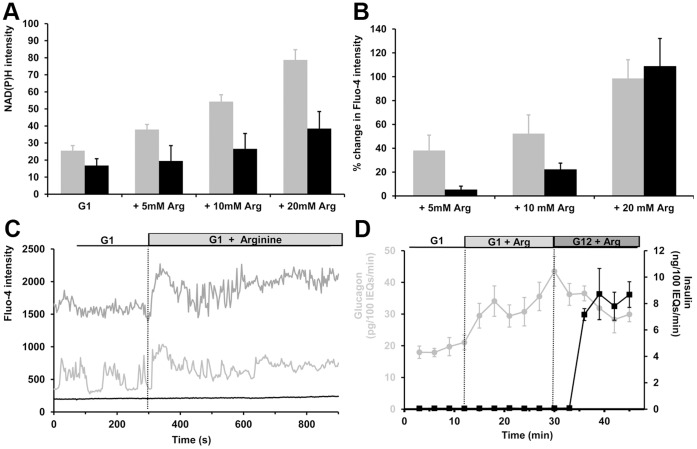
Effects of L-arginine on islet NAD(P)H, [Ca2+]i, and hormone secretion.Gray and black columns and traces represent α- and β-cells, respectively. A, arginine-dependent NAD(P)H responses from intact islets. Islets were perifused at 1 mM glucose (G1) and exposed to step-increases in arginine concentration. Data are normalized to minimal and maximal β-cell NAD(P)H obtained with FCCP and cyanide, respectively. The α-cell NAD(P)H changes to arginine (Arg) were statistically significant (p<0.01, 32 α-cells measured from 10 islets, 3 mice) and α-cell NAD(P)H intensity was different from β-cell intensity for each condition tested (p<0.01). Error bars indicate the standard error of the mean. B, averaged intracellular calcium responses to arginine. Data are expressed in percent change in Fluo-4 intensity compared to baseline at 1 mM glucose. α-cell responses to arginine were significant at all concentrations (p<0.01, n = 42) and β-cell responses were significant at 10 and 20 mM arginine (p<0.01, n = 11). C, intracellular calcium responses to 10 mM arginine from an islet perifused at 1 mM glucose (G1). 2 α-cells from the same islet are presented. Fluo-4 intensity is expressed in arbitrary units. The figure is representative of 11 α-cells from 4 islets. D, glucagon and insulin responses were measured for 9 minutes at 1 mM glucose, and then arginine was perifused at 10 mM for 18 minutes. Finally, glucose was added to the perifusion medium at 12 mM for 18 minutes. Experiment was repeated 4 times, 600 islets from 8 mice were used. Error bars represent the standard error of the mean.